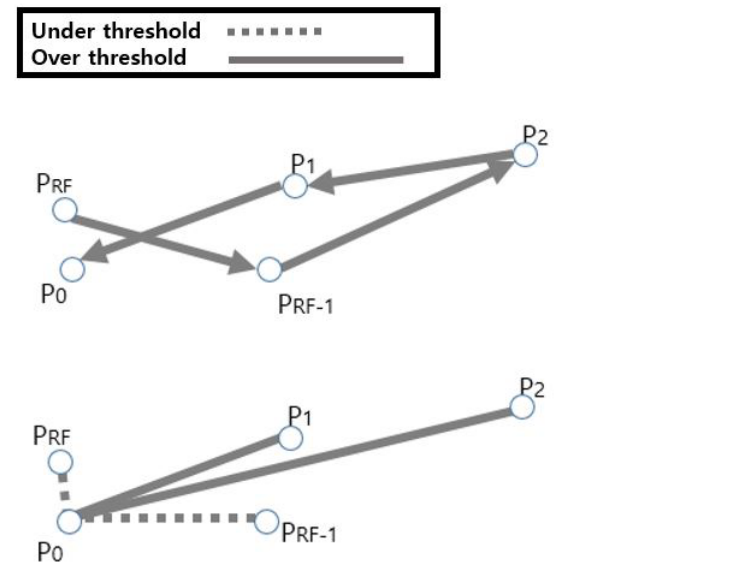
Figure 7. Locus of returning point (which is represented as a